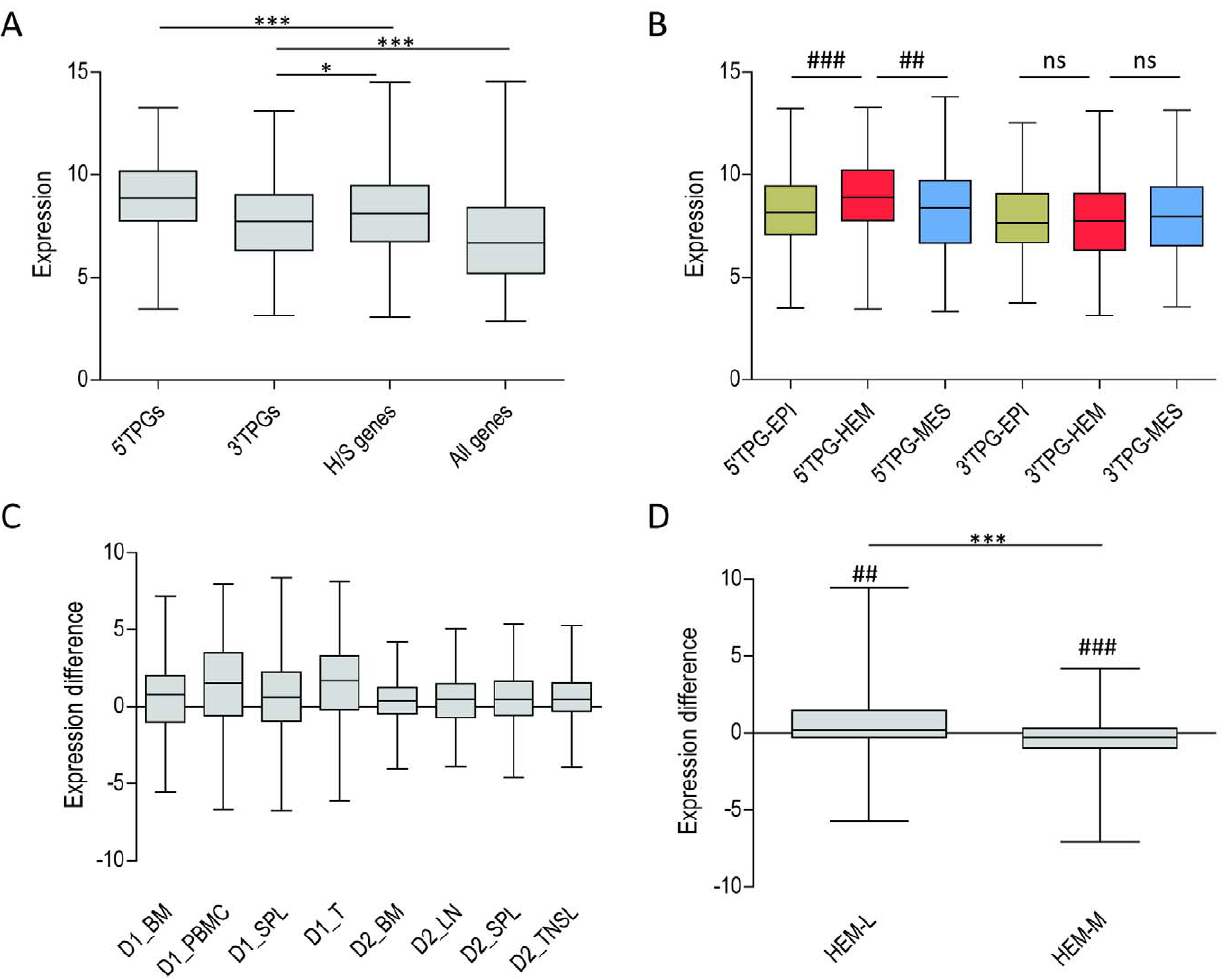
Figure 1. Expression of 5 9 and 3 9 TPGs. A : Average expression in hematological tissues of 5 9 and 3 9 TPGs compared to expression of all RefSeq genes (all genes) and a subset of genes known to be expressed in hematological tissue (H/S genes, according to UniProt database). B : Expression of TPGs in hematopoietic tissues (HEM) compared to non-hematopoietic tissues of epithelial (EPI) and mesenchymal (MES) origin. C : Expression difference between 5 9 TPGs and 3 9 TPGs in various samples of hematopoietic origin from two datasets (D1 and D2, see Methods): bone marrow (BM), peripheral blood mononuclear cells (PBMC), spleen (SPL), T-cells (T), lymph node (LN) and tonsil (TNSL). All differences are highly significant ( ### ). D : Difference in expression of 5 9 TPG between GM128 cell line (of lymphoid origin) and K562 cell line (of myeloid origin) for translocations reported in cells of lymphoid (HEM-L) and myeloid (HEM-M) origin. Higher value means more expression in GM128 compared to K562. Differences are significant in both groups, as indicated by Wilcoxon test. ***, **, *, ns: P , 0.001, 0.01, 0.05, Mann-Whitney U test. ### , ## , ns: P , 0.001, P , 0.01, non- significant, Wilcoxon signed rank test.